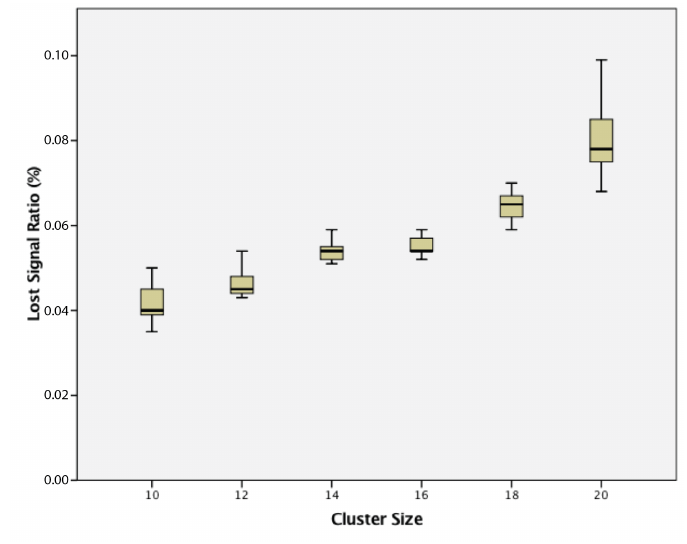
Figure 22. Lost signal ratio of clusters of dynamic wireless sensor nodes.